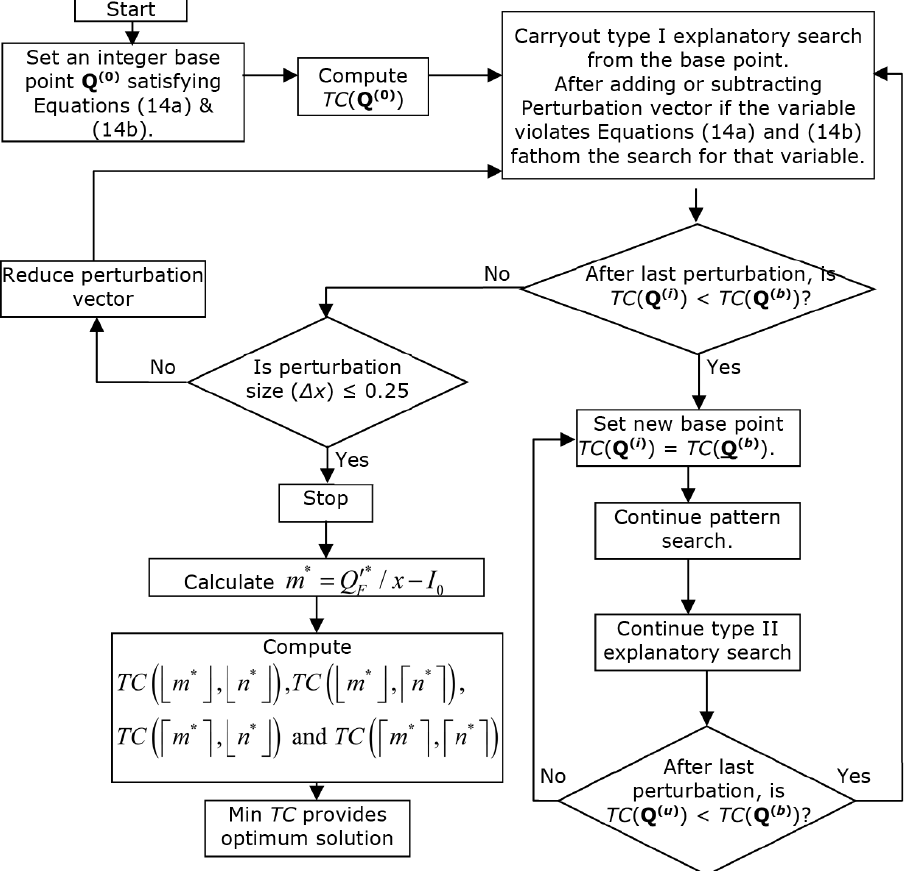
Figure 3. Flow chart of the Modified Hook and Jeeves